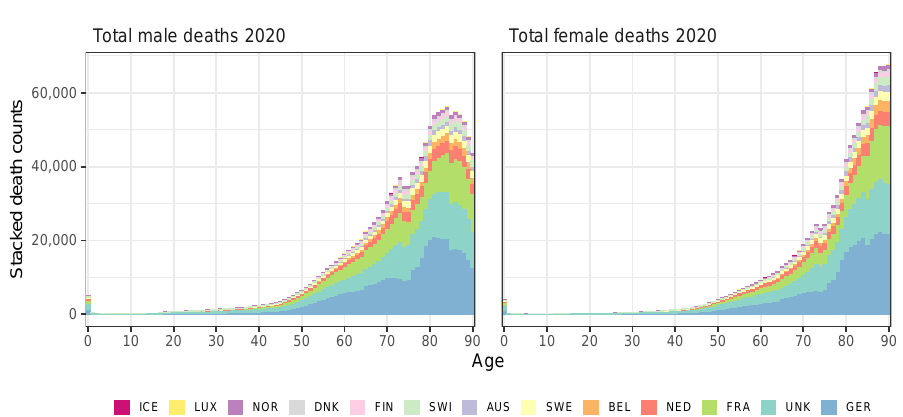
Figure 4. Stacked male ( left ) and female ( right ) death counts for the combined thirteen European countries in 2020 as a function of age. Death counts for the year 2020 are directly available from the HMD and Statbel for Denmark and Belgium, respectively. However, for Germany, United Kingdom, France, Netherlands, Sweden, Austria, Switzerland, Finland, Norway, Luxembourg and Iceland, we transform the weekly deaths collected in age buckets from the STMF data series or Eurostat to deaths at individual ages for the year 2020.